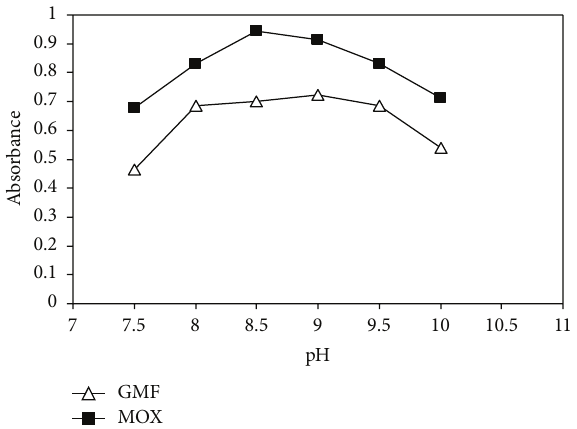
Figure 2: Effect of pH of borate buffer on the development of the reaction product of drugs with NBD-Cl at optimum temperature and time.